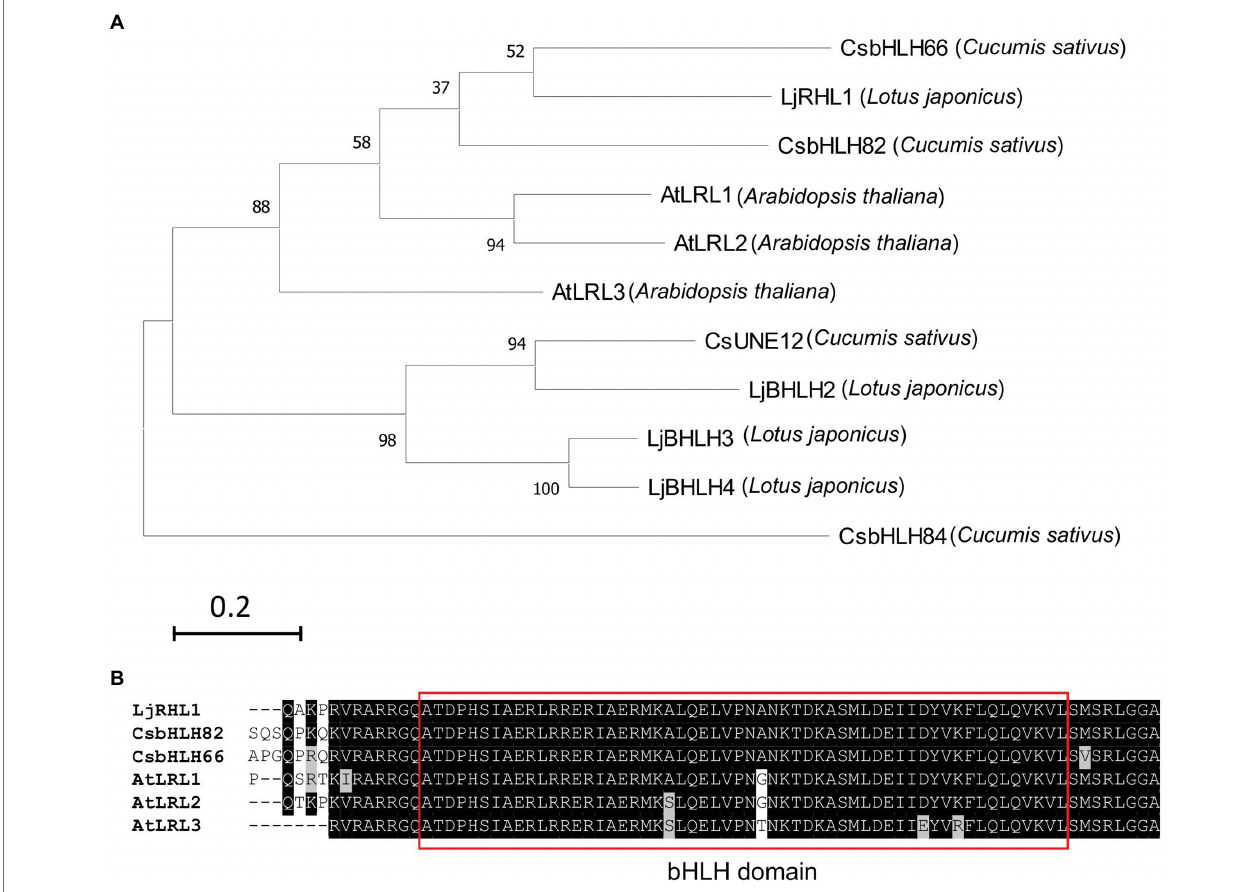
FIGURE 5 | The phylogenetic tree and sequence analysis of the LjRHL1 homologs. (A) Molecular phylogenetic tree of LjRHL1 protein sequence and its homologs were conducted by MEGA X using the maximum likelihood method and JTT matrix-based model. Numbers at nodes indicate the percentage bootstrap scores from 1,000 replicates. The scale bar represents 0.2 estimated number of amino acid substitution events per site. (B) Sequence alignment bHLH domain (in red box) of LjRHL1 in Lotus japonicus and its homologs in cucumber and